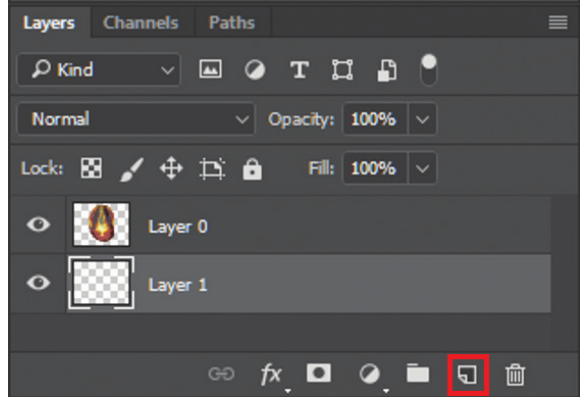
Figure 16. Layer panel with the “create new layer” icon highlighted.